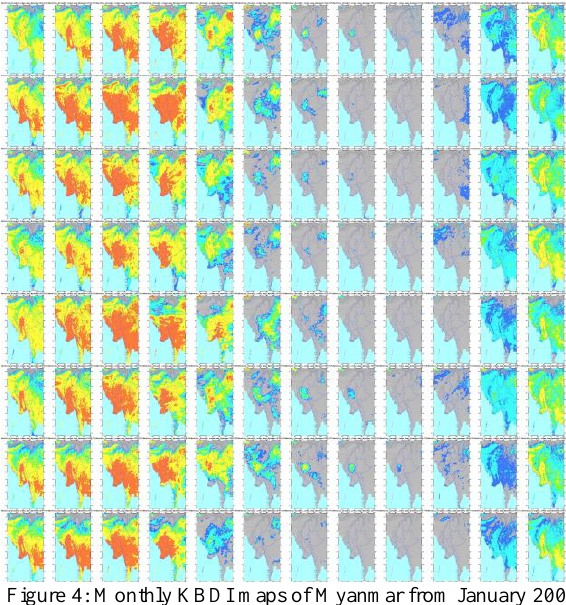
Figure 4: Monthly KBDI maps of Myanmar from January 2007 (bottom left) to December 2014 (top